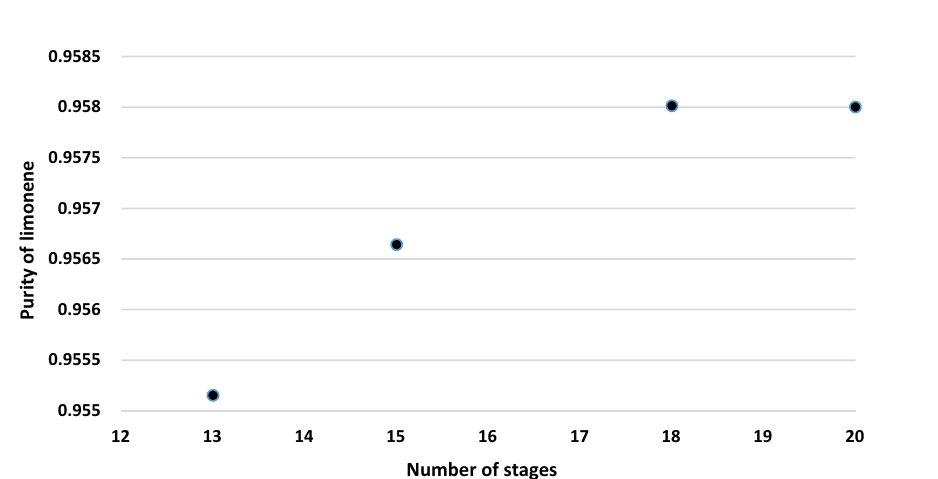
Figure 6. Influence of number of stages of second column on limonene purity.